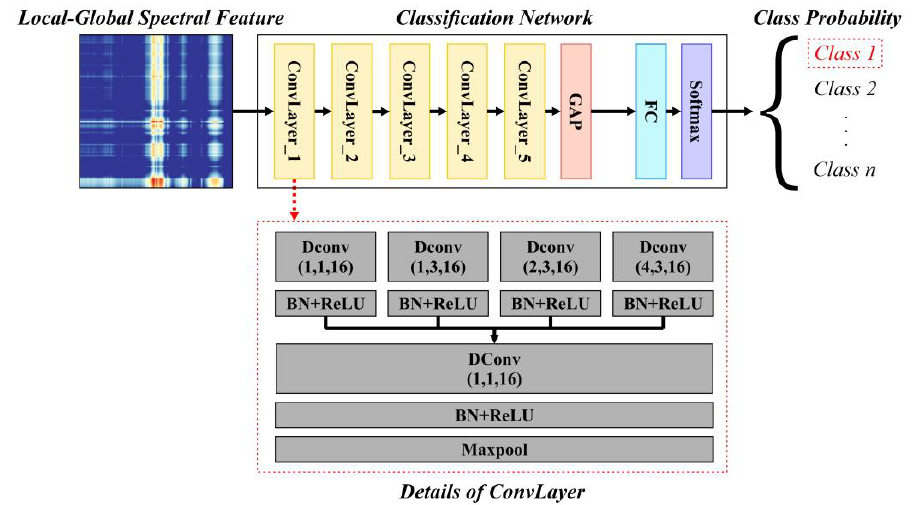
Figure 5. The architecture of the classification network. The input of the network is the LGSF, and the output of the network is the category of the pixel that generates the LGSF.